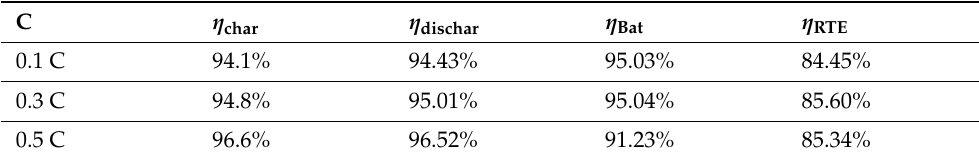
Table 3. Calculated efficiencies for different C values.